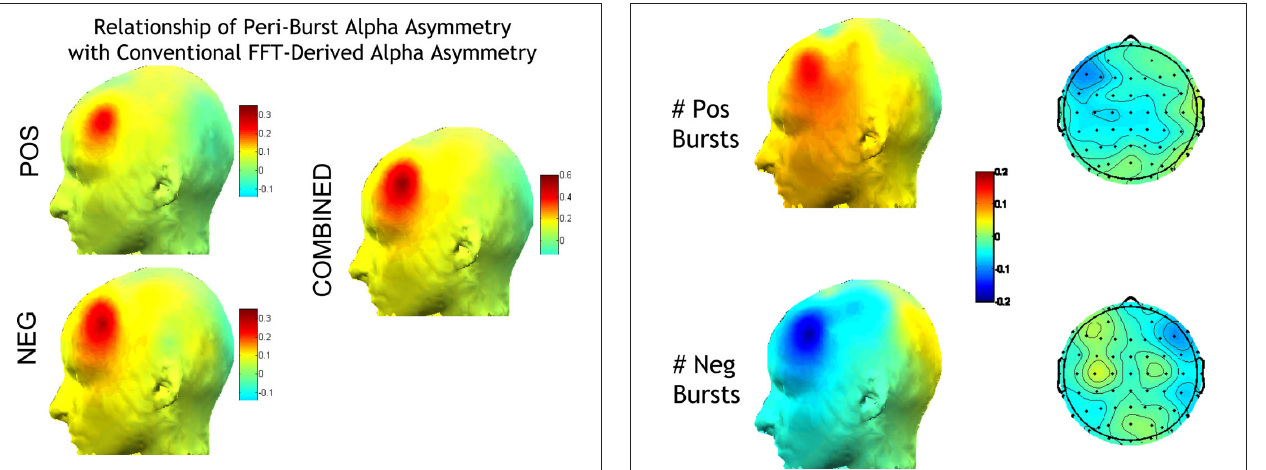
FIGuRE 6 | Correlations of number of positive and negative bursts with the conventional FFT-derived metrics. Left panel: correlation with the asymmetry score from all homologous EEG sites [ln(Right) − ln(Left)]; Right panel: correlations with ln-transformed alpha power at individual sites. Correlations are shown separately for the number of positive bursts (top) and for the number of negative bursts (bottom). A greater number of positive bursts is associated with relatively greater ln(R) − ln(L) FFT-derived asymmetry scores, and less left frontal alpha. A greater number of negative bursts is associated with relatively lower ln(R) − ln(L) FFT-derived asymmetry scores, and less right frontal